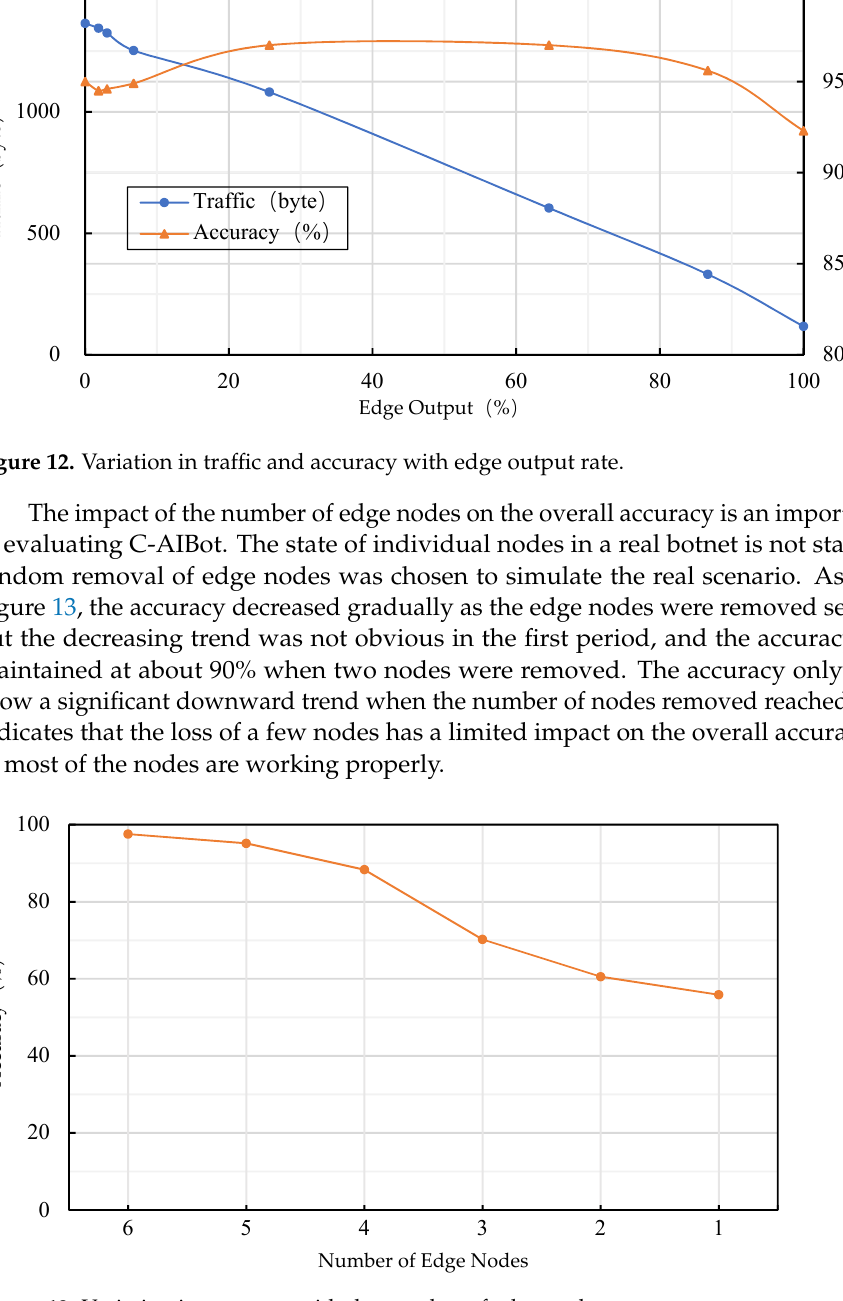
(16) Figure 11. Impact of Th. The communication traffic in C-AIBot consists of two main components: the traffic generated by sending inference results from the edge nodes to the sink, and the traffic generated by the edge nodes by uploading the output of the underlying neural network to the cloud. Figure 12 gives the variation in communication traffic (in bytes) and accu-